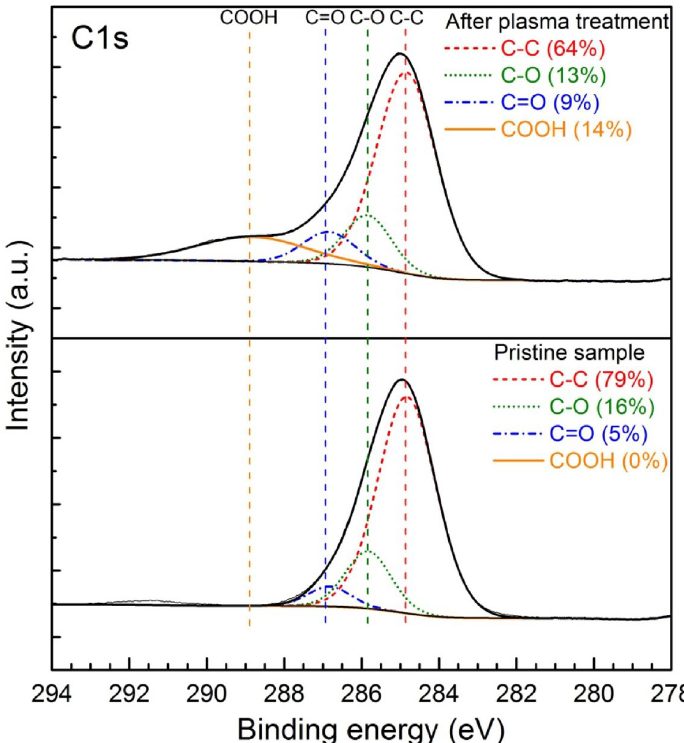
Figure 12. XPS analysis of C1s peak of PMMA polymer before and after plasma treatment measured in a binding energy interval of 294–278 eV. Argon flow rate 20 NL/min. Microwave power 460